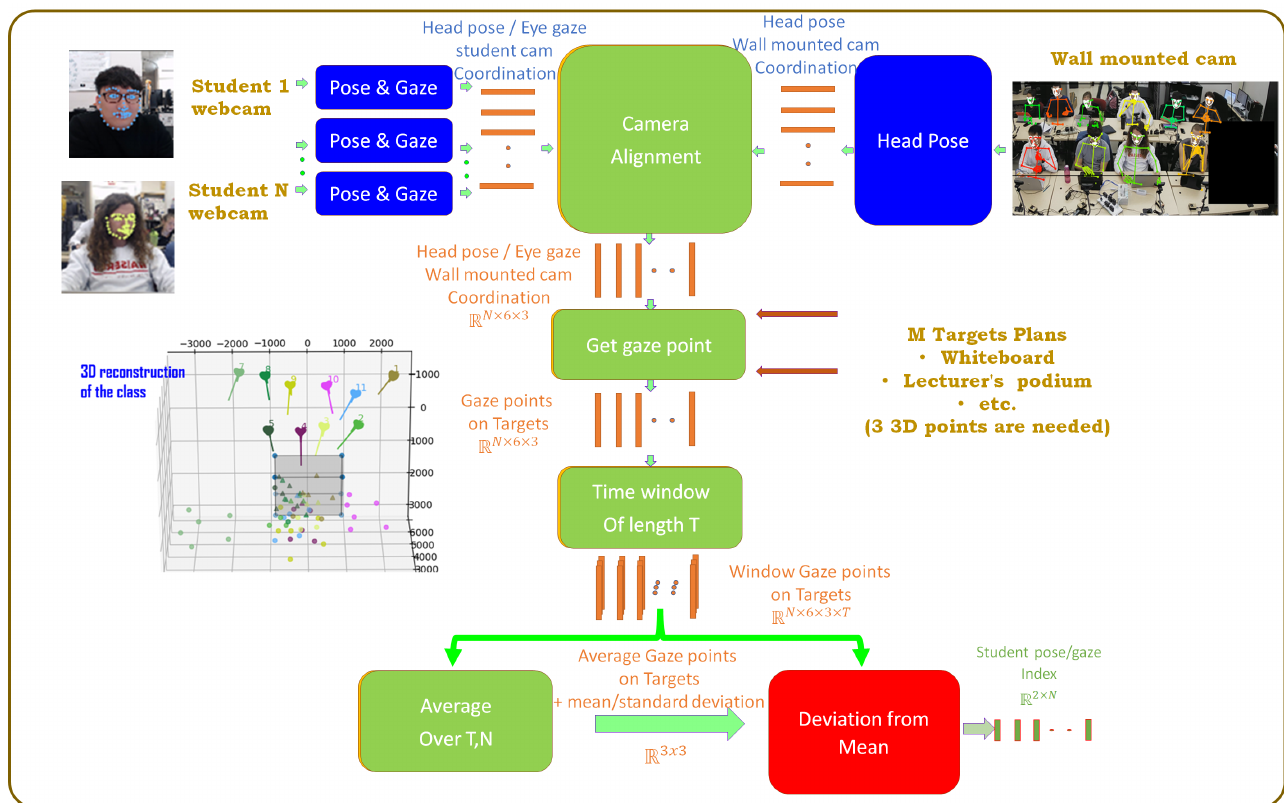
Figure 3. The proposed behavioral engagement